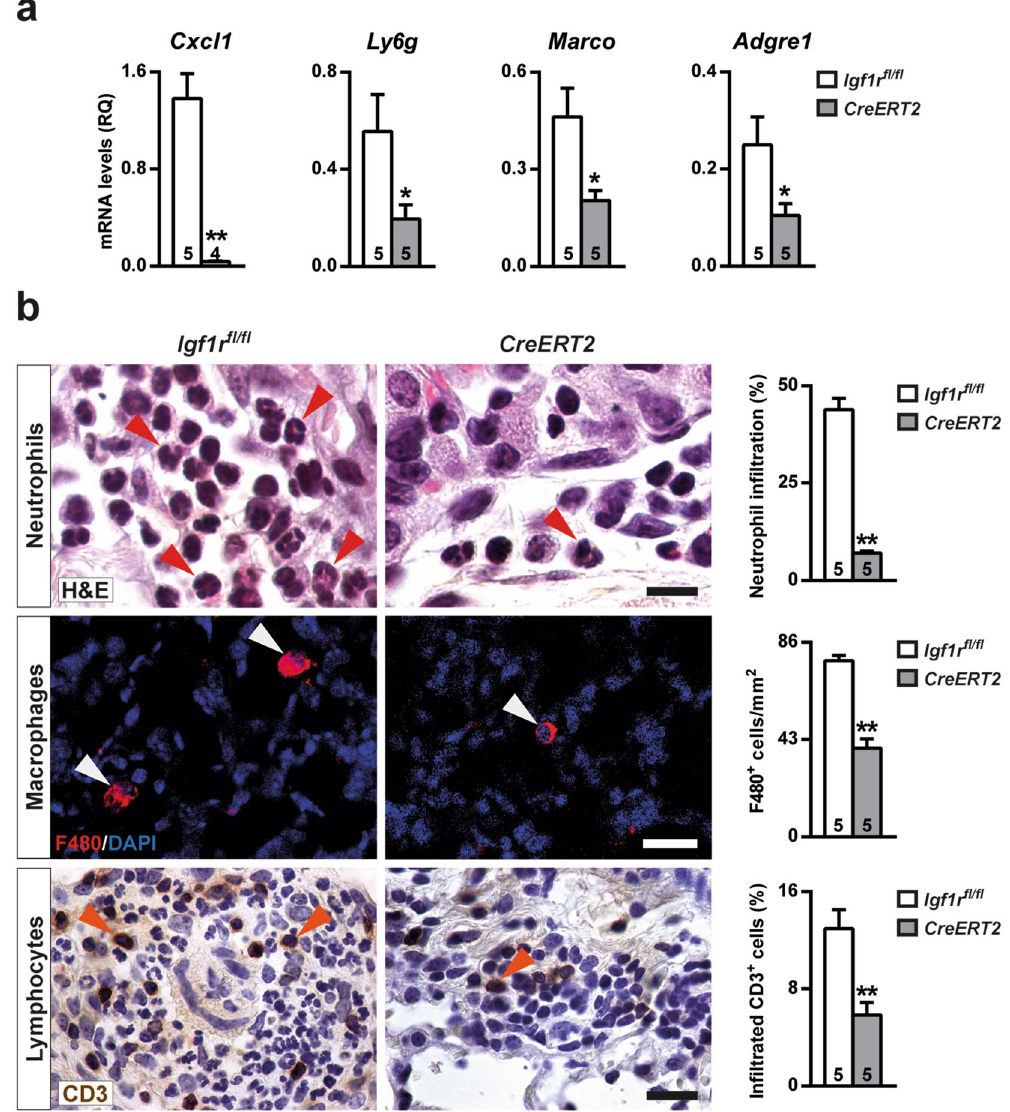
Figure 6. Reduced inflammatory cell infiltration in IGF1R-deficient lungs after BLM treatment. ( a ) Lung mRNA expression of neutrophil chemotaxis ( Cxcl1 ), neutrophil ( Ly6g ) and macrophage ( Adgre1 and Marco ) markers and ( b ) representative H&E, as well as F4/80 and CD3 immunostained sections, and quantification of neutrophils (red arrowheads, upper panels), alveolar macrophages (white arrowheads, middle panels) and lymphocytes (orange arrowheads, bottom panels) in BLM treated UBC-CreERT2 ; Igf1r fl / fl ( CreERT2 ) vs . Igf1r fl / fl lungs at D3. Scale bars: 10 μ m (upper panels) and 20 μ m (middle and bottom panels). Numbers within graphic bars indicate the number of mice analyzed and data are expressed as mean ± SEM. * p < 0.05; ** p < 0.01 (Mann- Whitney U